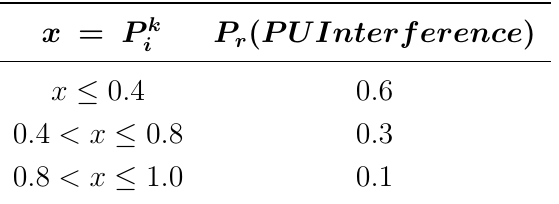
Table 4. PU interference probability index